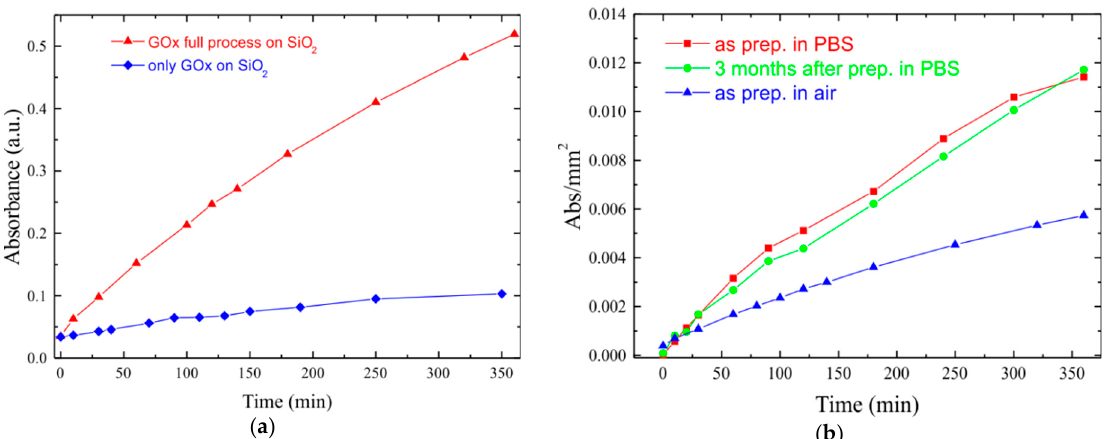
Figure 7. ( a ) GOx activity as a function of time for a SiO 2 sample fully processed ( red triangles ) and in solution ( blue diamonds ). ( b ) Effect of storage conditions on enzymatic activity of GOx coated SiO 2 samples stored (2 days) in air ( blue triangles ) or in PBS ( red squares ) and stored in PBS for 3 months ( green circles ).